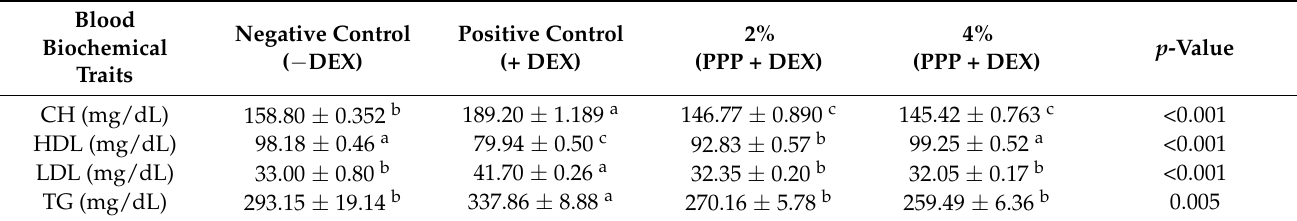
Table 5. Effect of different levels of dietary pomegranate peel on some biochemical parameters of laying hens subjected to oxidative stress.